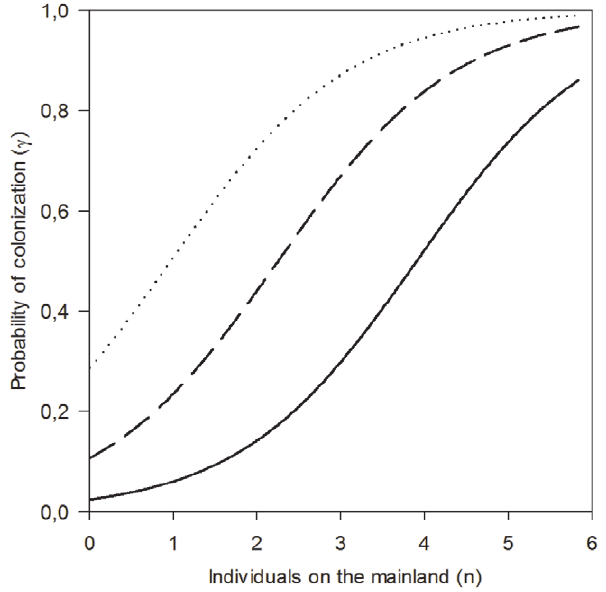
Figure 4. Probability of extinction. The relationship between the probability of extinction ( e ), population density index on the island the previous season (POPISL) and maximum water lever (WMAX; 255 m=solid line, 256 m=broken line, 257 m=dotted line).